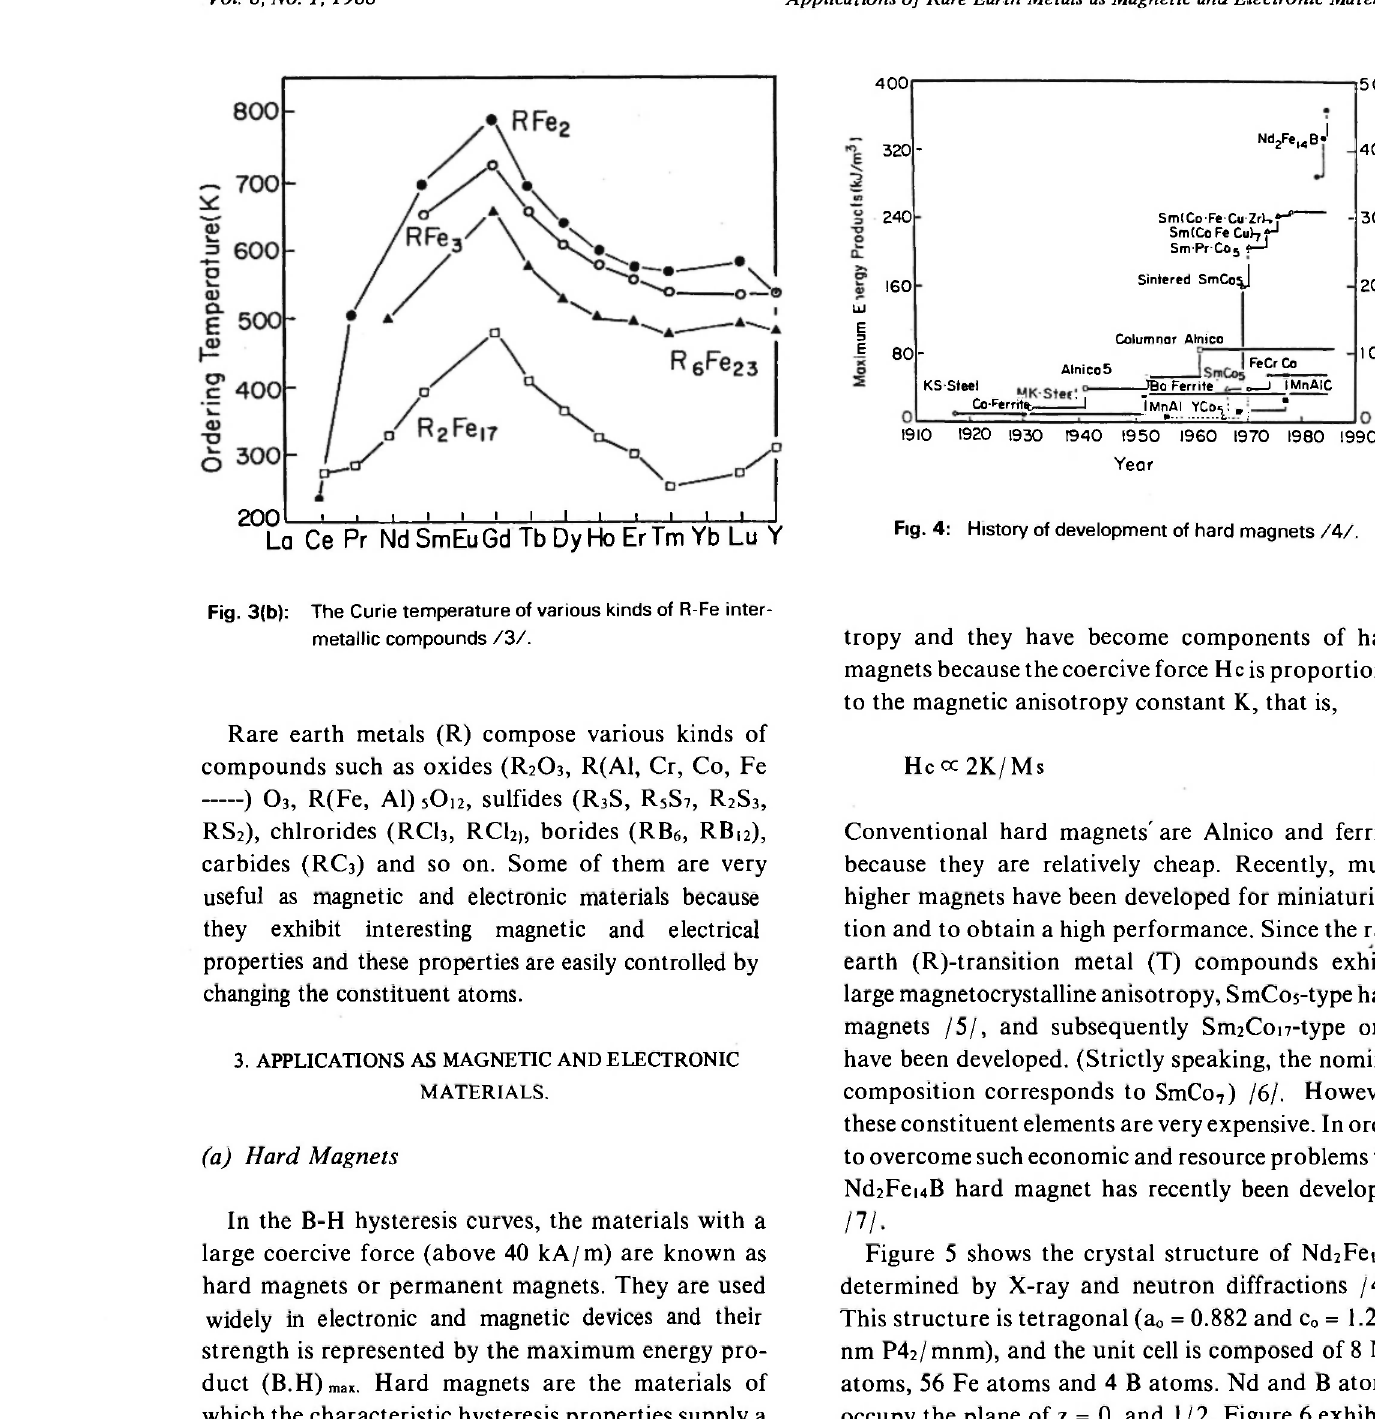
Fig. 3(b): The Curie temperature of various kinds of R-Fe inter- metallic compounds